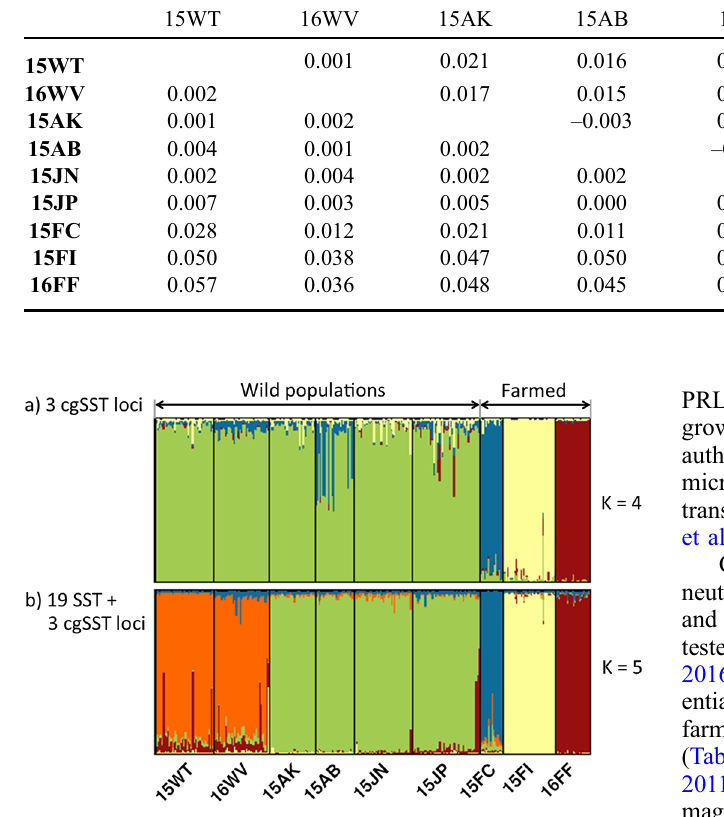
Fig. 2. Black horizontal lines divide individuals from different sampling sites.' with 'Black vertical lines divide individuals from different sampling sites. See Table 1 for abbreviated sample